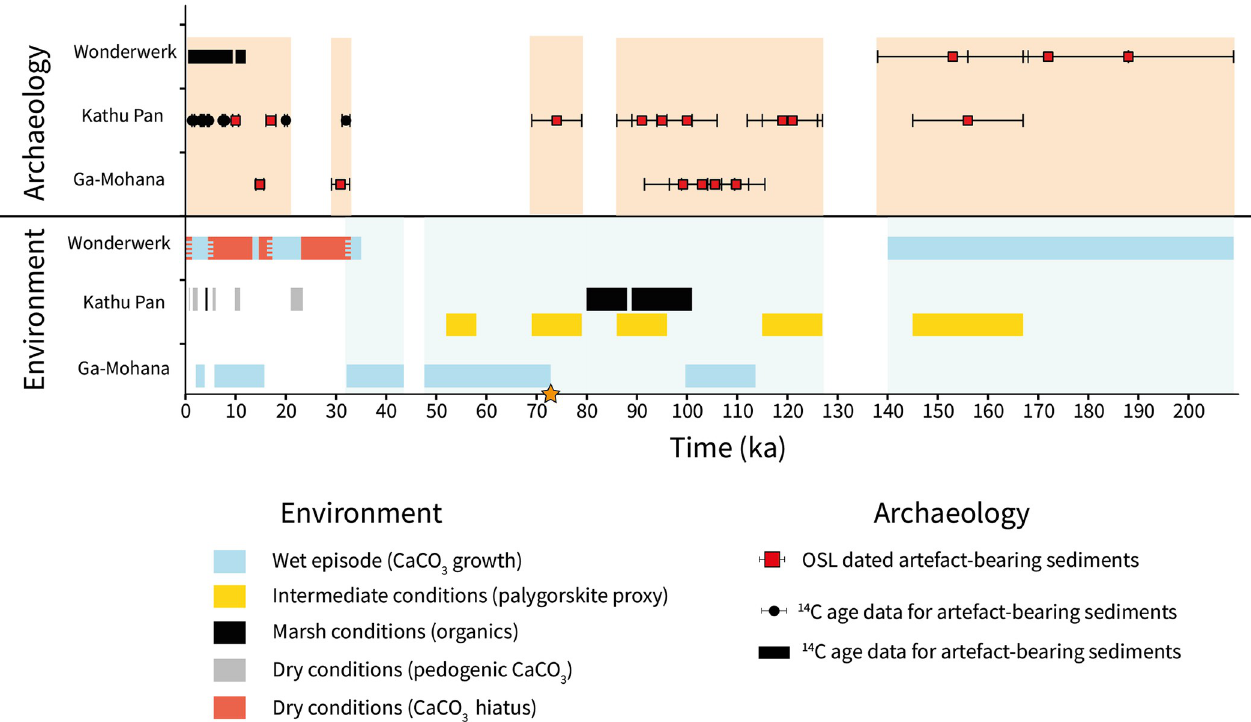
Fig 4. Comparison of palaeoenvironmental and archaeological records from Ga-Mohana Hill, Kathu Pan, and Wonderwerk Cave. Archaeological occupation ages for Ga-Mohana Hill [27, 36], Kathu Pan [25, 26, 91, 92] and Wonderwerk Cave [20, 93, 94]. Pale orange bars highlight periods of occupation. Palaeoenvironment proxy data from Ga-Mohana Hill (this study), Kathu Pan [25] and Wonderwerk Cave [19, 20]. Pale blue bars highlight wet periods across the sites. Orange star marks the point at ~71 ka, before which human occupation of the region appears to have been associated with the availability of water.